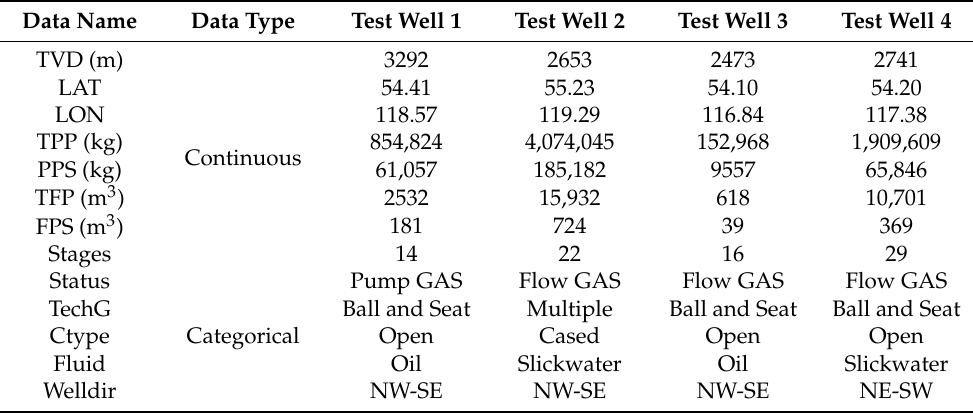
Table 10. Input parameters for four test